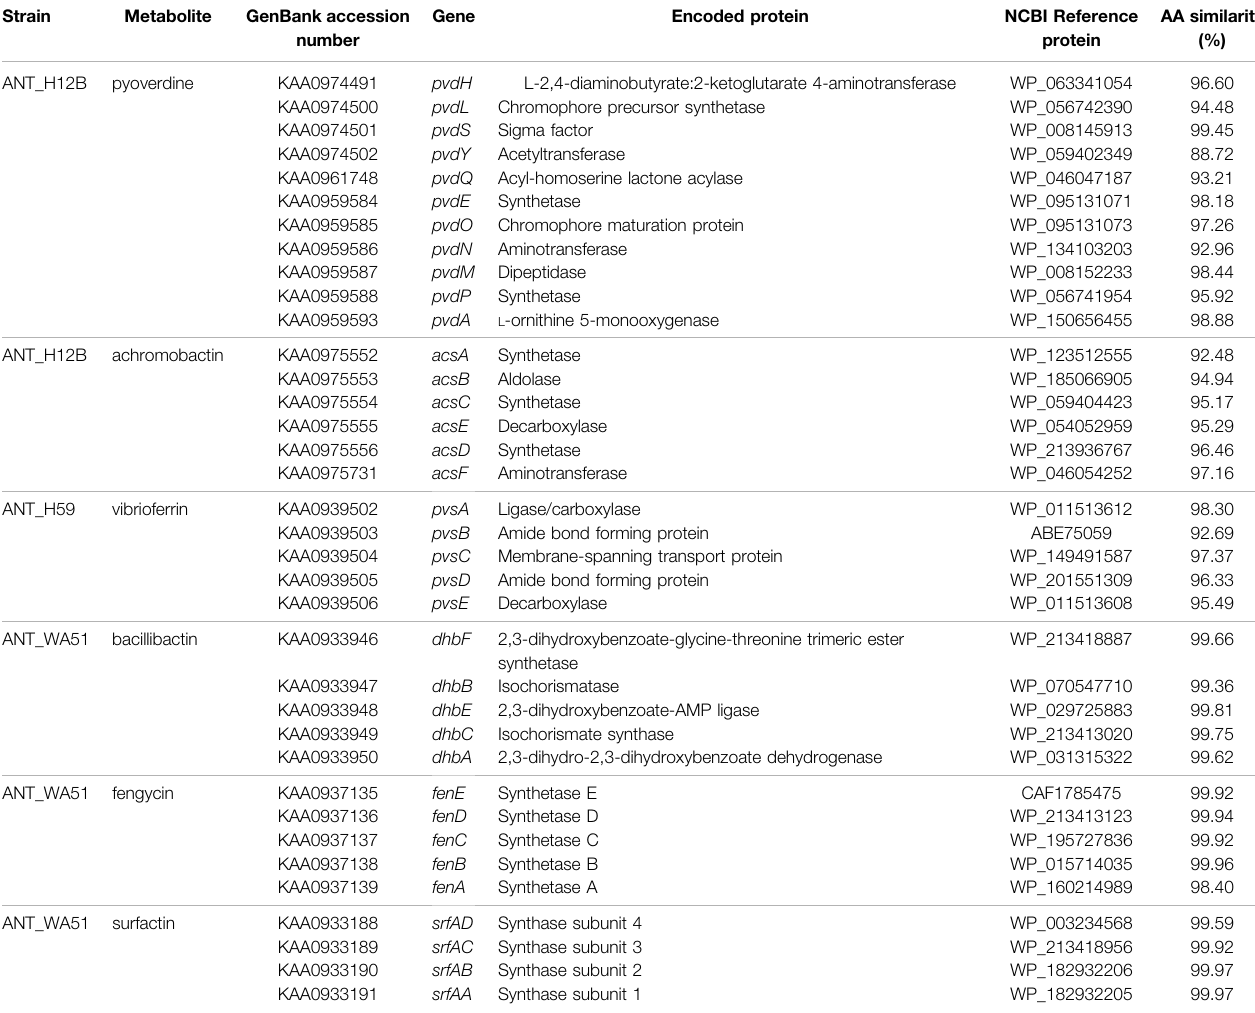
TABLE 2 | Siderophore and biosurfactant biosynthesis genes encoded by ANT_H12B, ANT_H59 and ANT_WA51. NCBI — National Center for Biotechnology Information; AA — amino acids.